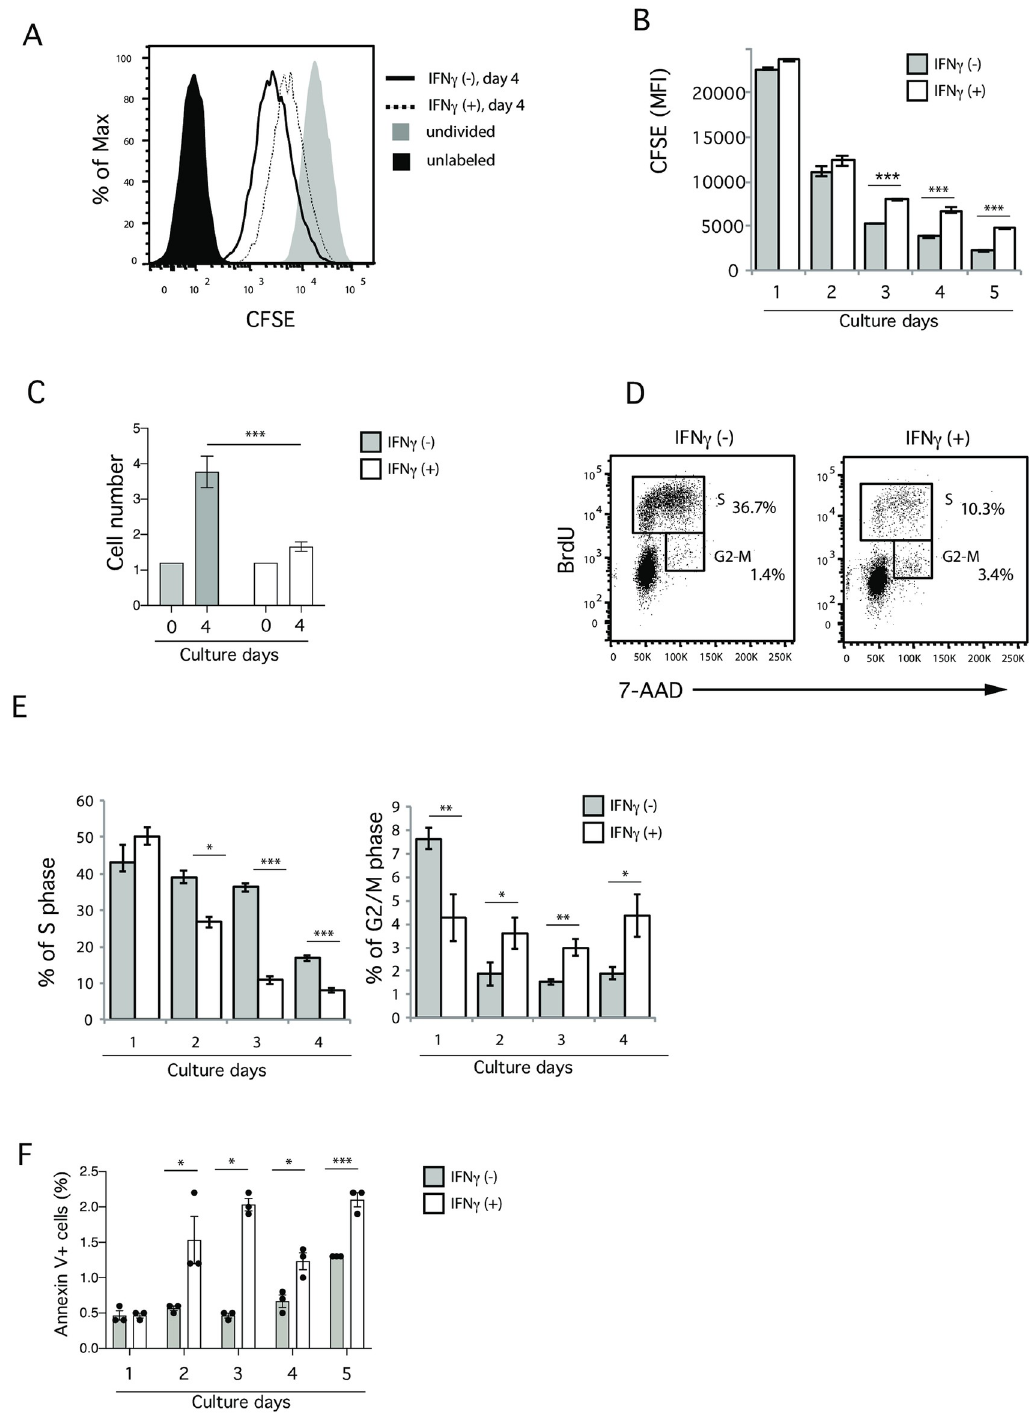
Fig 1. IFN γ inhibits Th2 cell proliferation. (A) Flow cytometry showing the mean fluorescence intensity (MFI) of CFSE dilution on day 4 of IFN γ treatment. (B) The MFI of Th2 cells cultured in the presence or absence of IFN γ on the indicated number of days. (C) The cell number was determined after 4 days of culture of IL-2 in either the presence or absence of IFN γ . (D) A cell cycle analysis of Th2 cells after 4 days of culturing in the presence or absence of IFN γ . BrdU incorporation (final four hours) was measured to determine the distribution of cells at each stage of the cell cycle. (E) The frequencies of cells in the S phase (left) and G2/M phase (right) on the indicated number of days are shown. (F) Annexin V + cells were determined on the indicated days of IFN γ treatment. Data are representative of three independent experiments. Error bars represent the mean ± SD. � , �� , and ��� p < 0.05, p < 0.01, and p < 0.001, respectively (Student’s t -test).